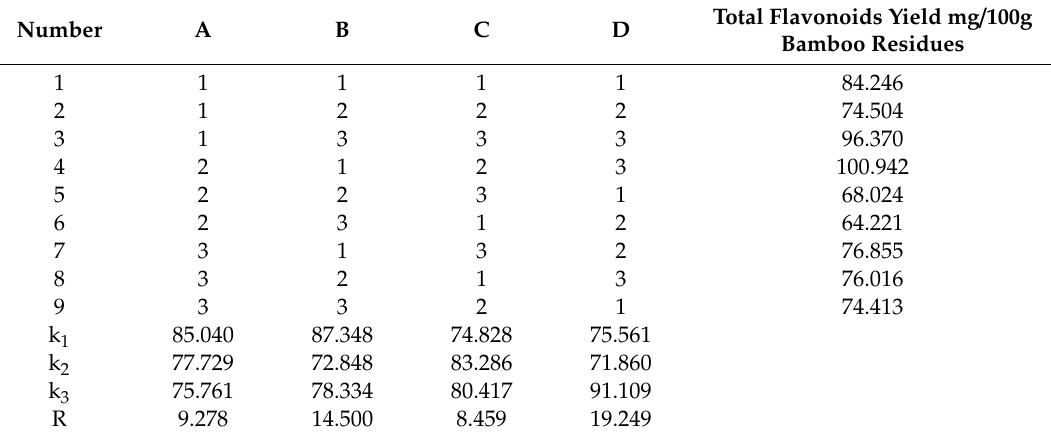
Table 2. Design and results of L 9 (3 4 ) orthogonal experiment.